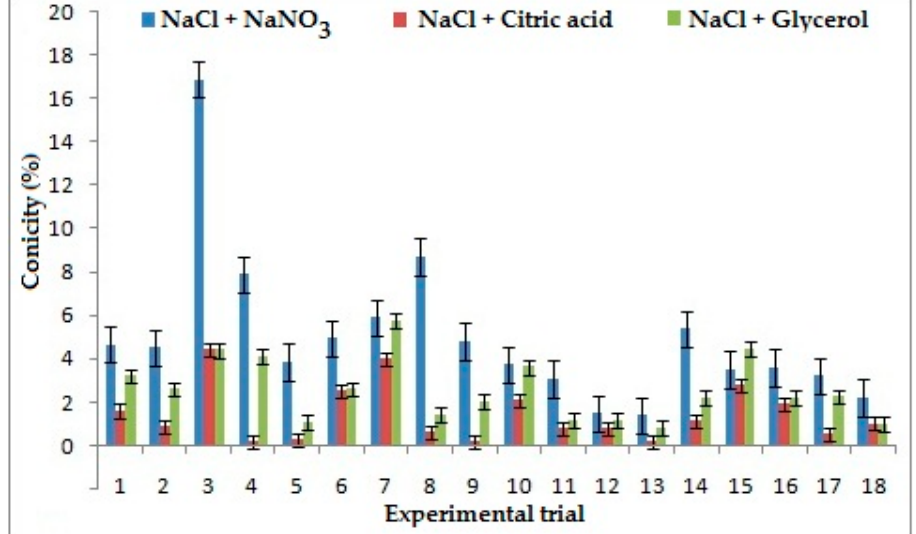
Figure 5. Effects of electrolytes and process parameters on conicity .